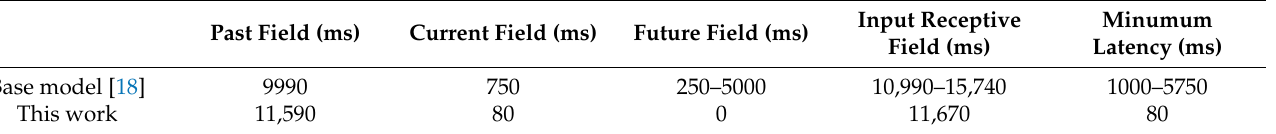
Table 2. Comparison of the base model [18] and a simplified model of this work.